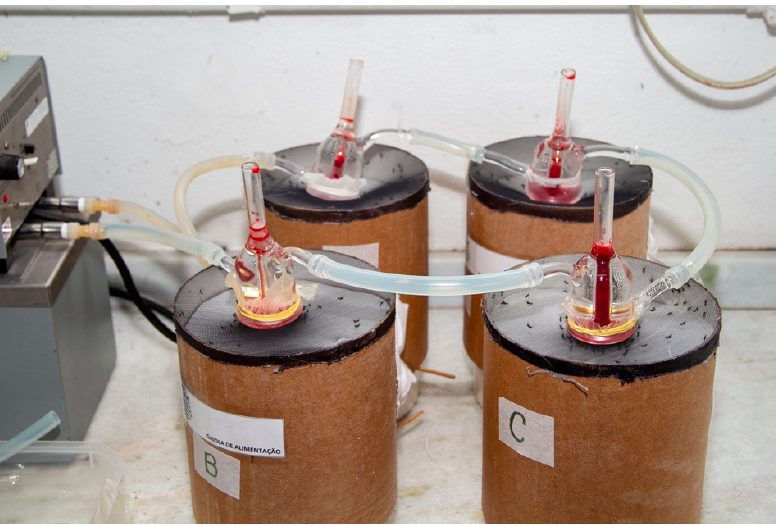
Figure 1. Artificial blood-feeding system for mosquitoes: four cages with retractable bottoms. Feeders filled with human blood are on top of the cages.